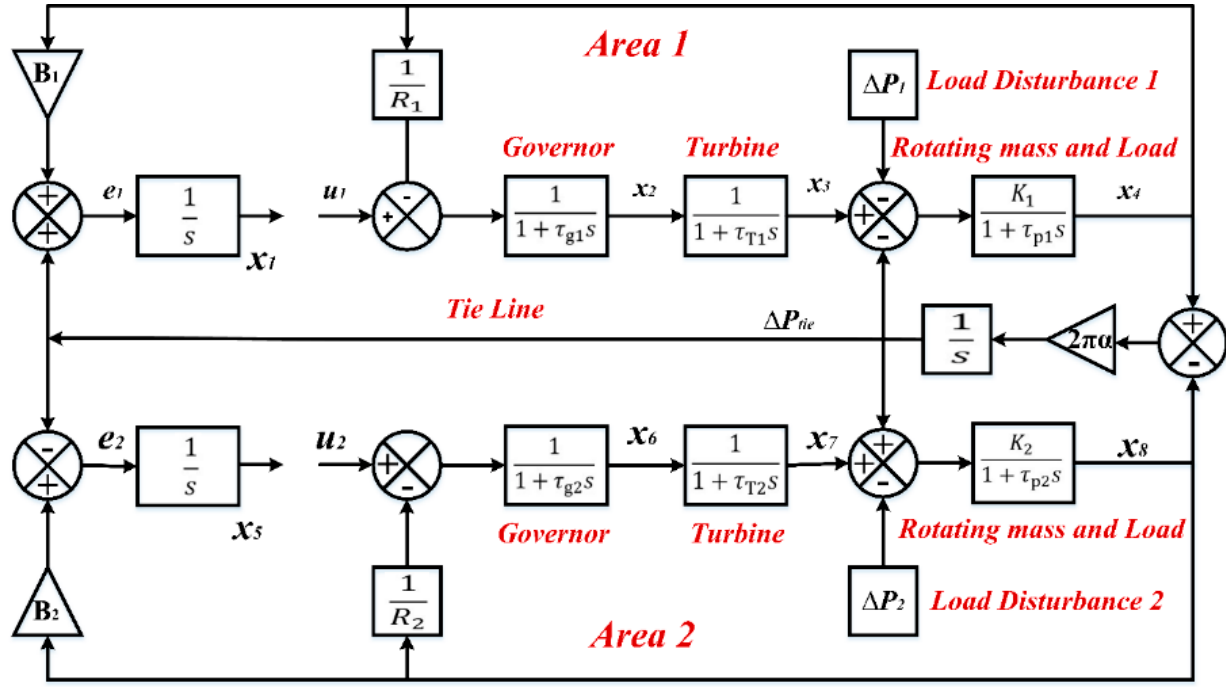
Figure 2. Modelling of two-area power system.